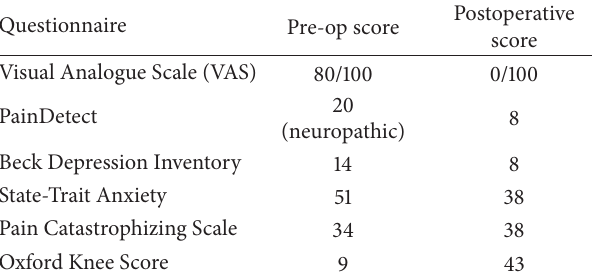
Table 2: Pre- and post-TKR questionnaire